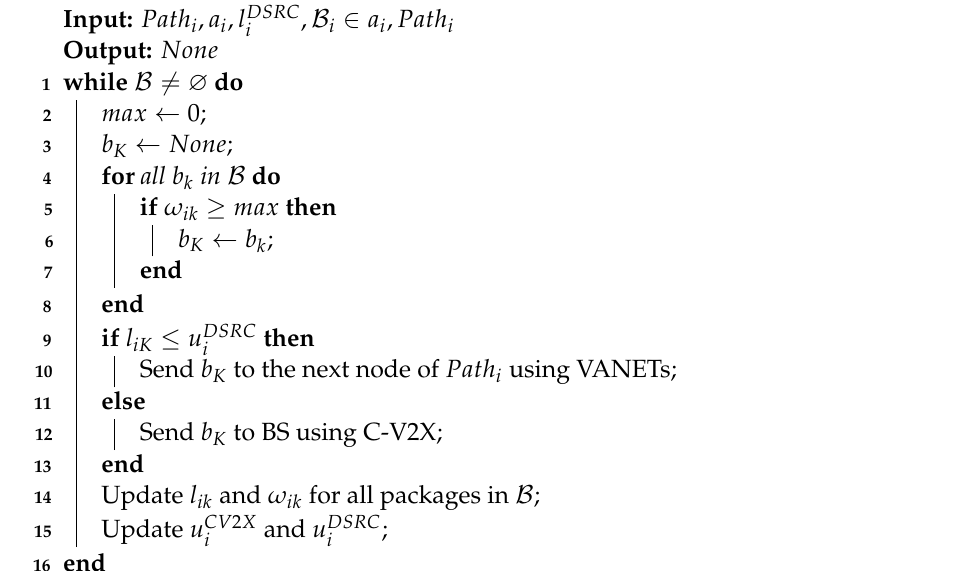
Algorithm 3: Routing Policy. The algorithm used to choose which way (DSRC or C-V2X) to send the